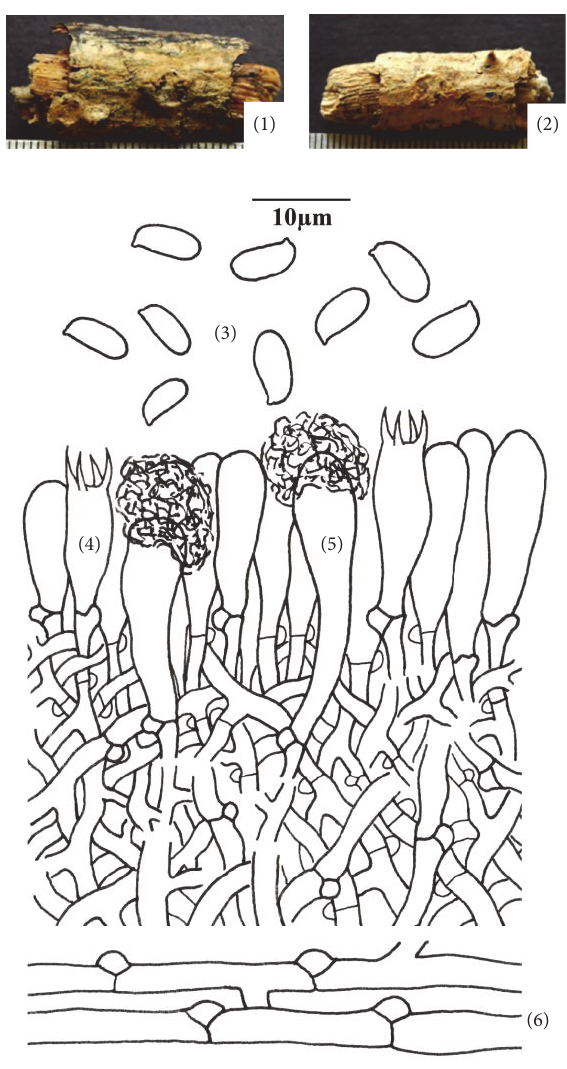
Figure 1: Hyphoderma clavatum (1)–(6). (1) Fresh basidiocarp, (2) dried basidiocarp, (3) basidiospores, (4) basidium, (5) cystidium, and (6) generative